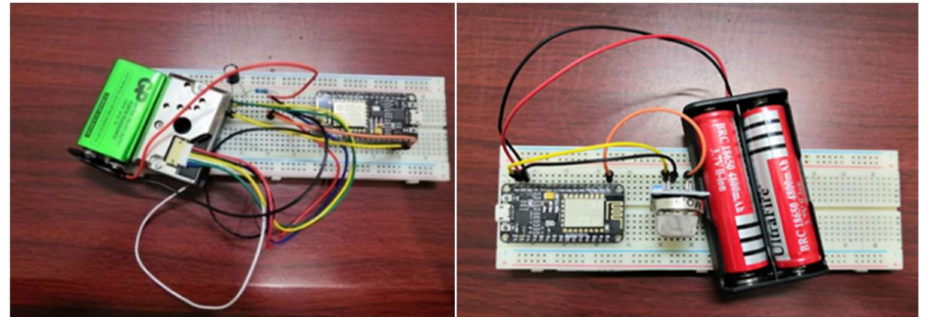
Figure 17. ( a ) Dust sensor; ( b ) smoke